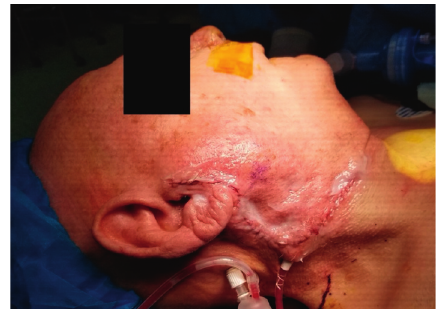
Figure 2: Wound closure after volume